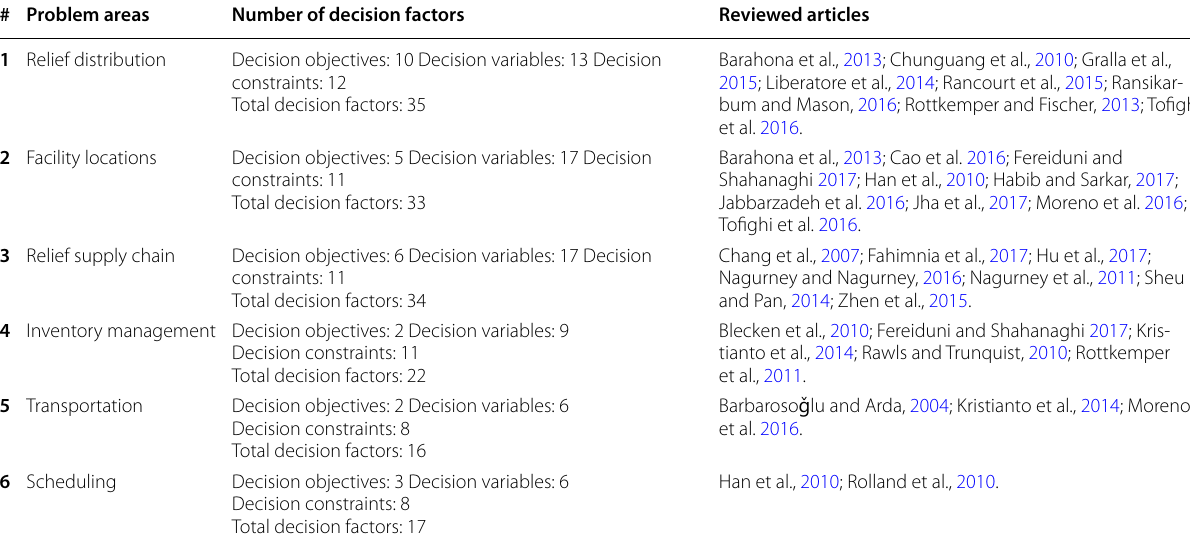
a Please contact the first author for detail. Problem area specific decision factors are not included